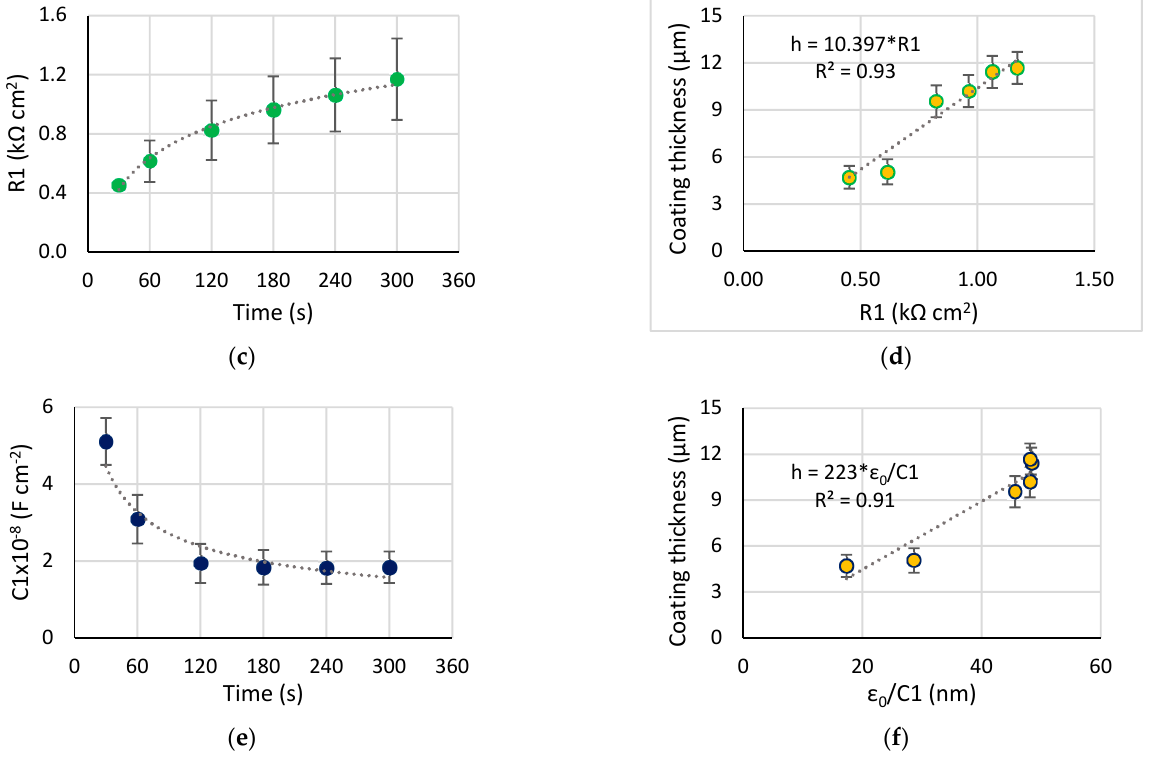
Figure 9. In situ parameters characterizing the Ti PEO, and calibration lines for the coating thickness estimation: ( a ) evolution of ln( I 1 / I 2 ) calculated from the optical emission; ( b ) calibration line for the coating thickness estimation via the optical emission method; ( c ) evolution of R1 calculated from the in situ impedance spectroscopy; ( d ) calibration line for the coating thickness estimation via R1; ( e ) evolution of C1 calculated from the in situ impedance spectroscopy; ( f ) calibration line for the coating thickness estimation via C1. Materials 2022 , 15 , x FOR PEER REVIEW